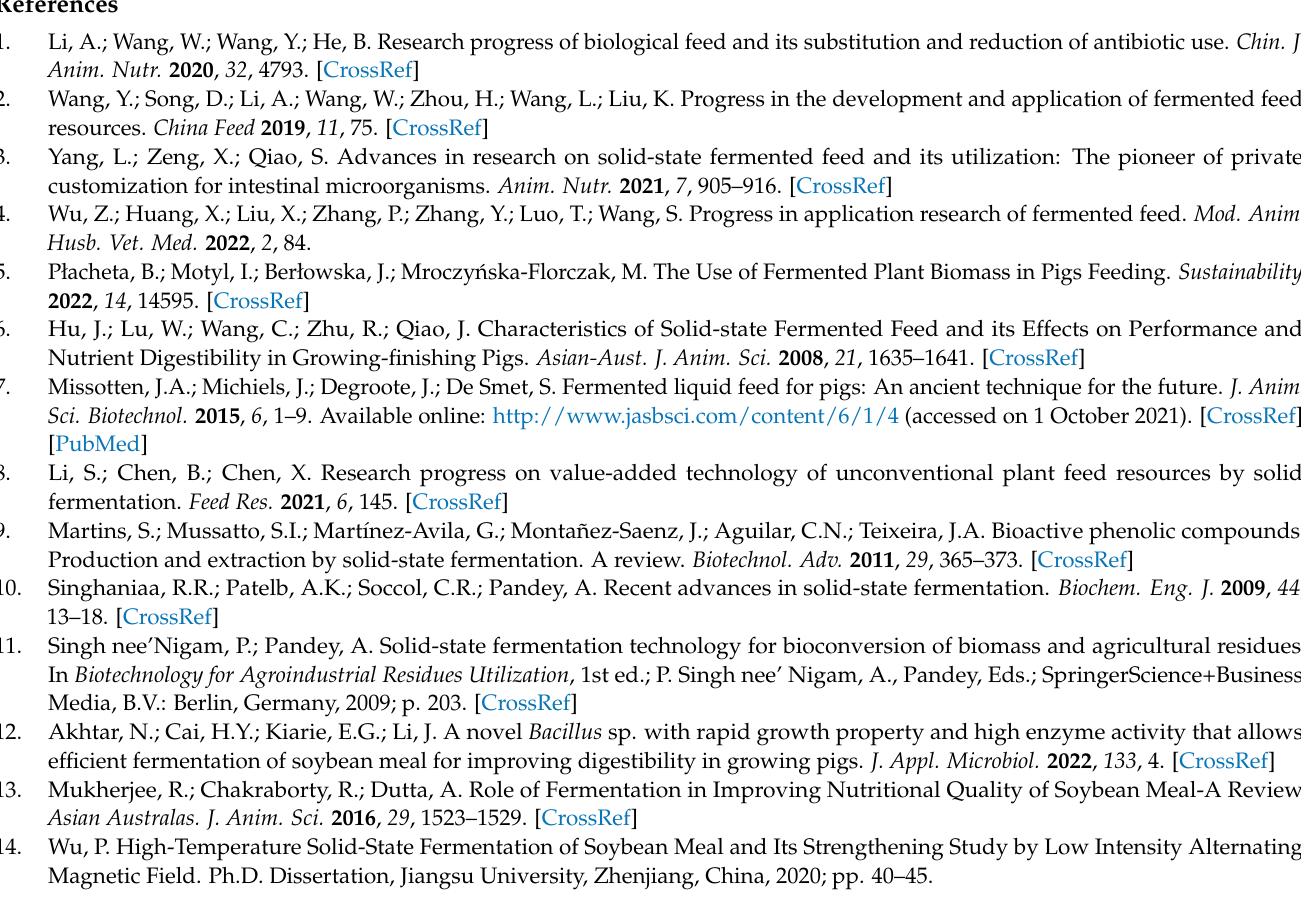
Table S3: The relative abundance data for the top ten fungi at the species level; Table S4: The results of the Salmonella test; Figure S1. The standard curve for proteins obtained with the biuret method. Figure S2. Morphological picture of strain SLB-04. Figure S3. 16S rDNA phylogenetic tree con-structed on the base of maximum likelihood